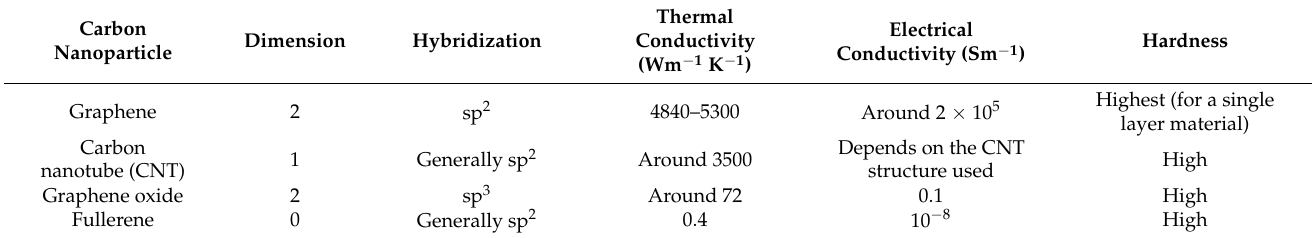
Table 1. Comparison between various properties of different carbon nanoparticles. Data adapted from